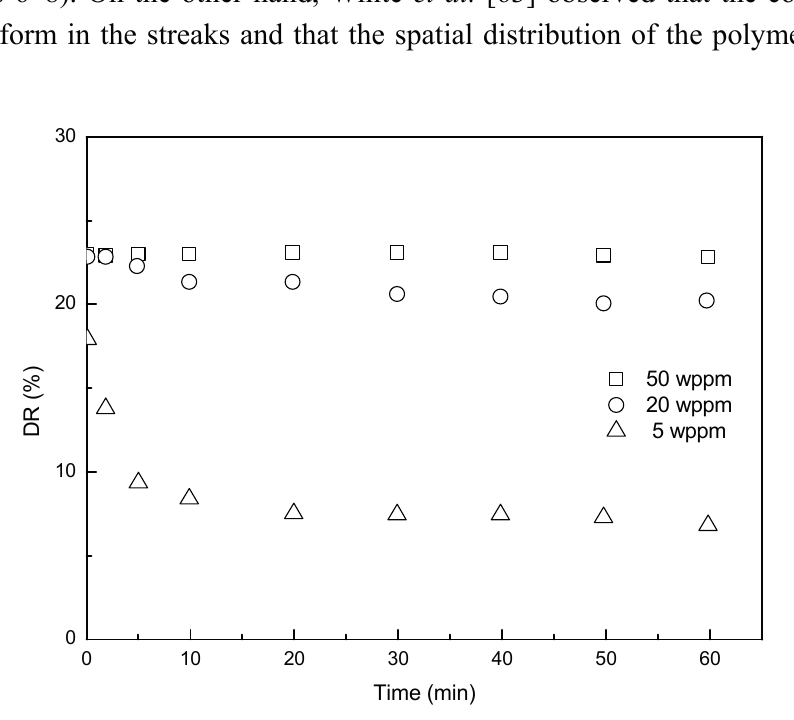
Figure 6. DR as a function of time at 2800 rpm for three different PAAM (Reprinted from [54]).